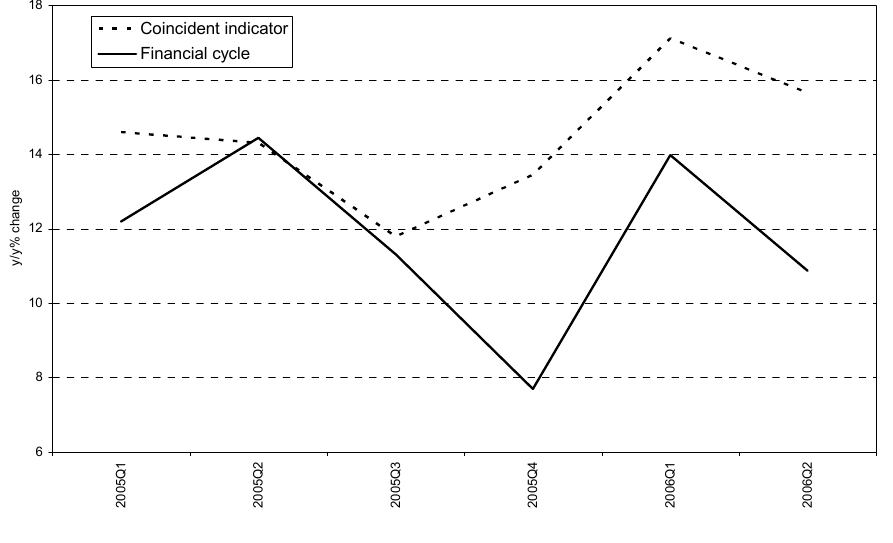
FIGURE 6: Out of sample performance of the financial